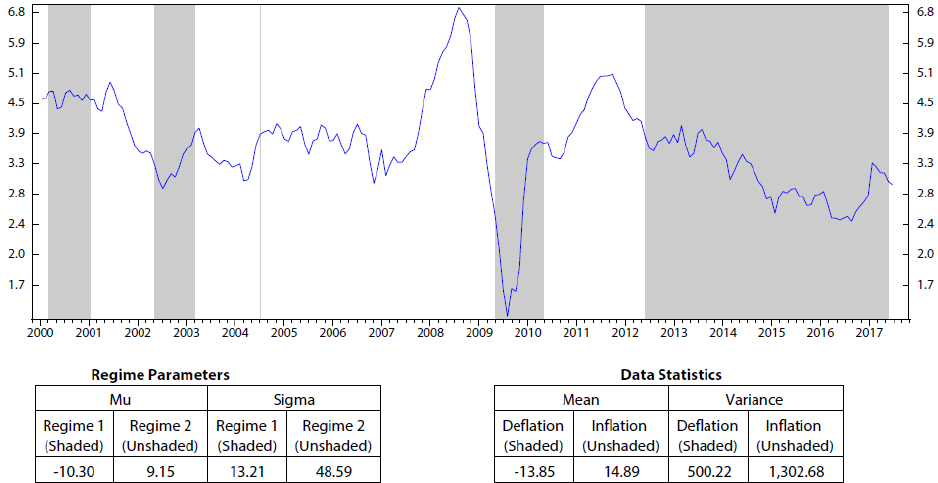
Figure A1. The world inflation and its regimes detected using HMM for monthly data from 31 December 1999 to 31 August 2017. Regime 1 and regime 2 represent deflation and inflation periods, respectively.